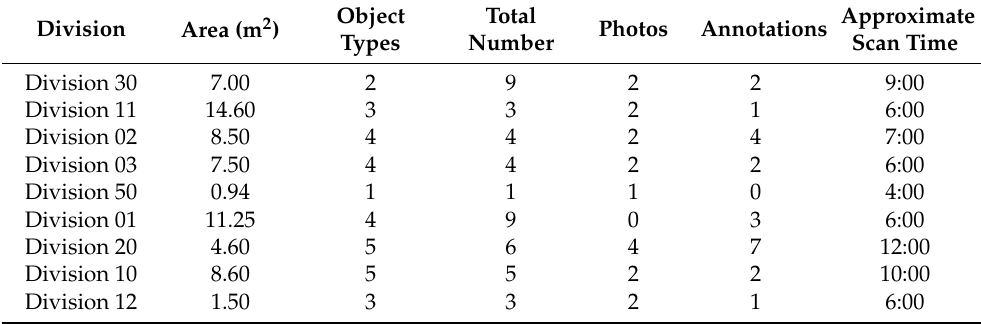
Table 5. Summary of the scan process of all divisions on the sample apartment.